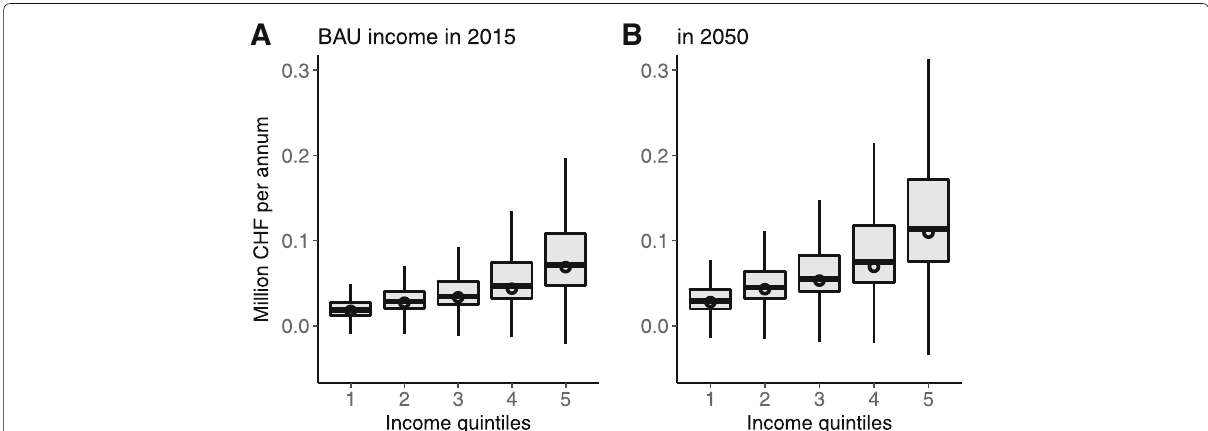
Fig. 4 Distribution of income as measured by the model within and across income quintiles in 2015 ( a ) and in 2050 ( b ). Note: Income quintiles are according to allocation by the statistical office. The circles show mean values